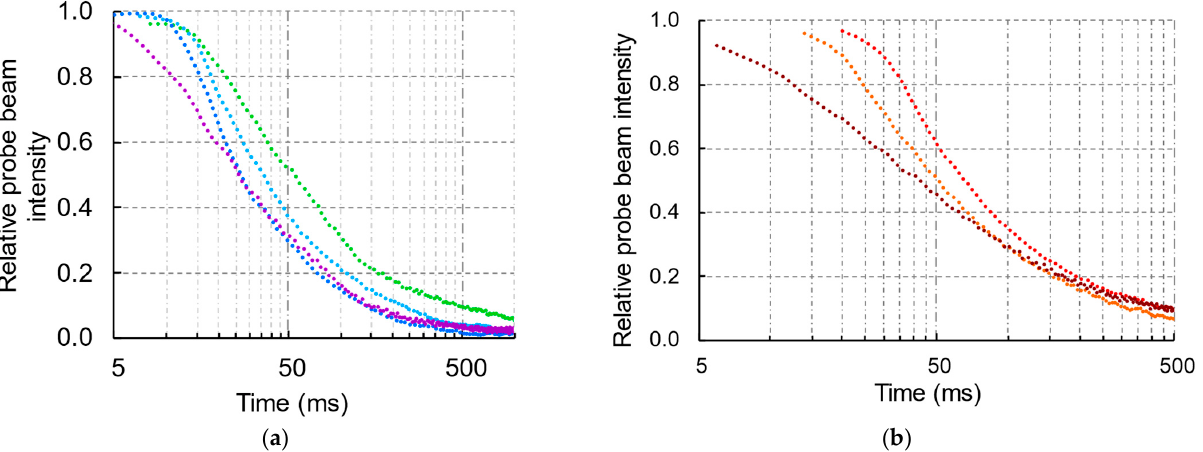
Figure 9. Normalized transient thermal-lens curves for the heating stage: ( a ) hemoglobin cyanide in PBS (0.2 µM, green; 0.8 µM, light blue; 1.5 µM, blue; and 3 µM, magenta) and ( b ) starting parts of transient curves for ferroin (red line) and hemoglobin cyanide (dark red line) with the same absorbance, with the orange line in between corresponding to a 1:1 molar mixture of ferroin and hemoglobin cyanide; for clarity, the X-axis is in the logarithmic scale. Setup, TLS-60; excitation wavelength, 514.5 nm; excitation power, 40 mW. The delay of the formation start is caused by opening of the mechanical shutter.